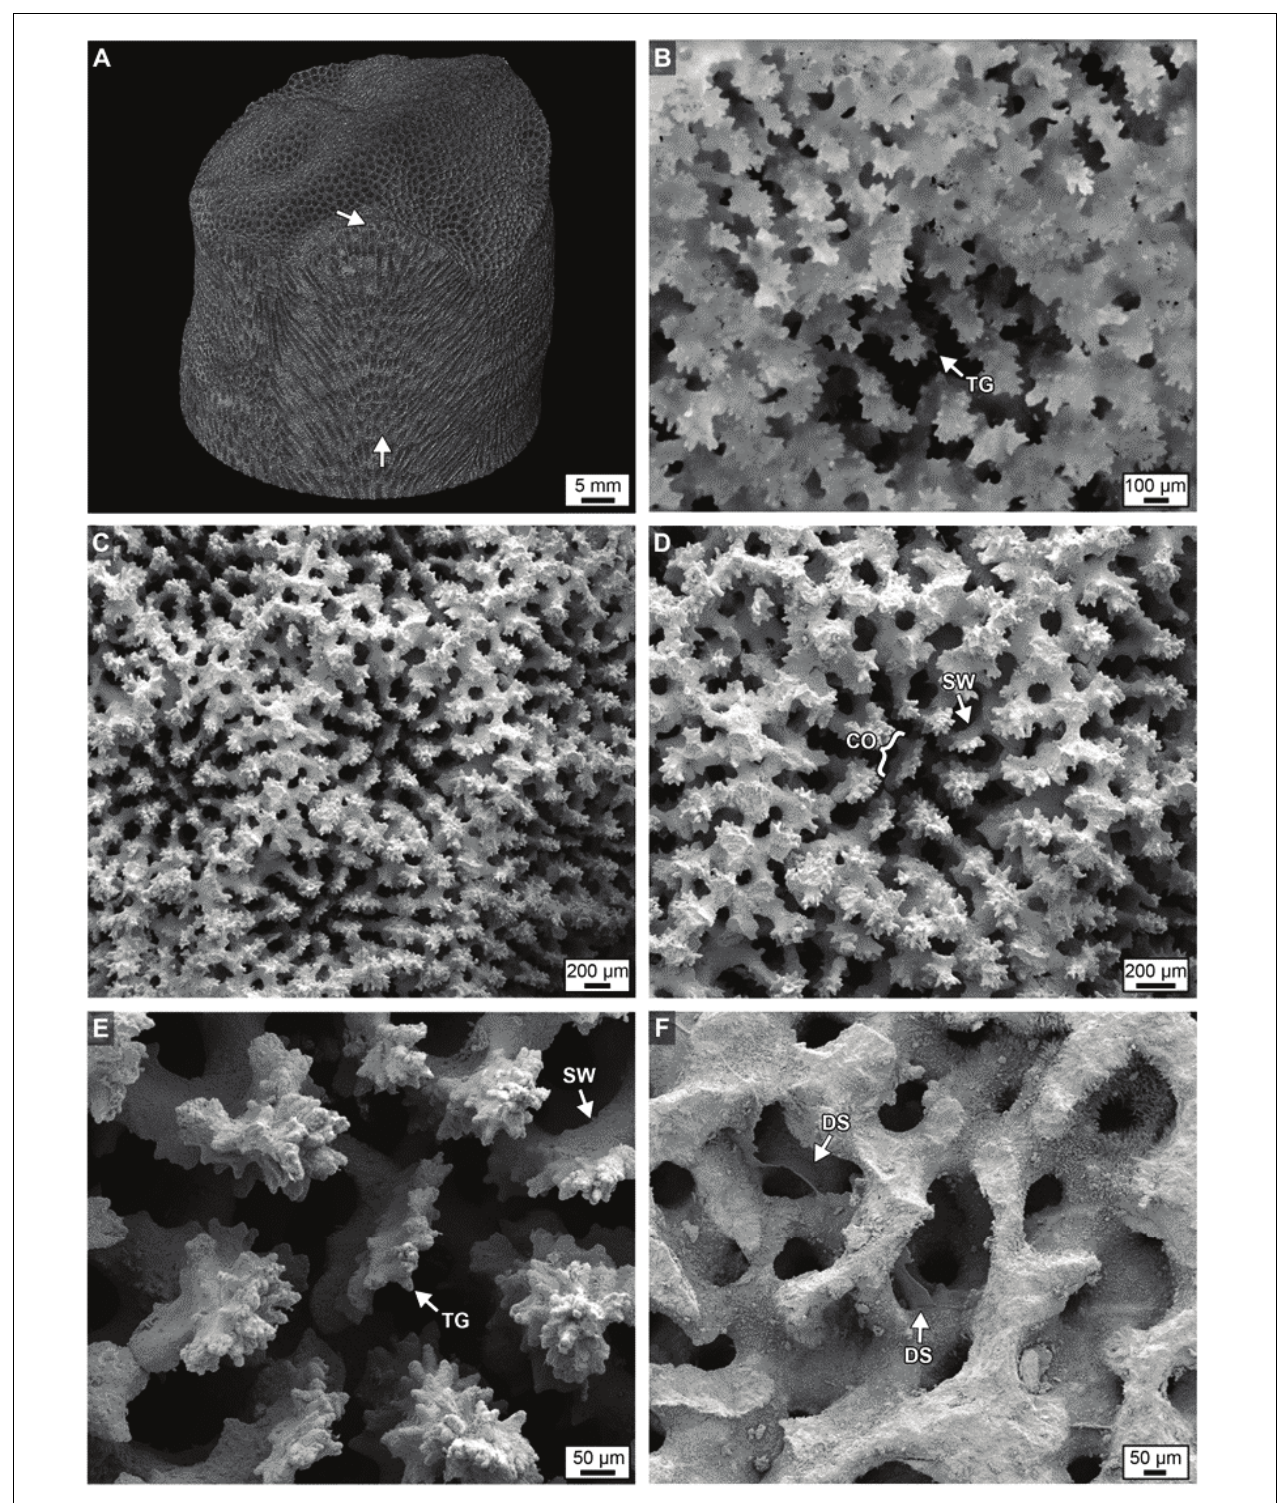
FIGURE 3 | (A) A volume rendered maximum intensity projection of 3D MicroCT image from the top of Core 3 showing spiraling corallite bundles (white arrows) and their bumpy cm-scale surface expression (see also Supplementary Data Movies S1a,b ). (B) An extended depth of focus image under brightfield (BF) of an original Porites corallite. (C–E) Scanning electron microscope (SEM) images of original Porites corallites. (F) Scanning electron microscopy (SEM) image of DS within coral skeleton. Labeled components in all images include: CO, columella; SW, skeletal wall; and TG, teeth and granule growing from SW; DS, dissepiments.